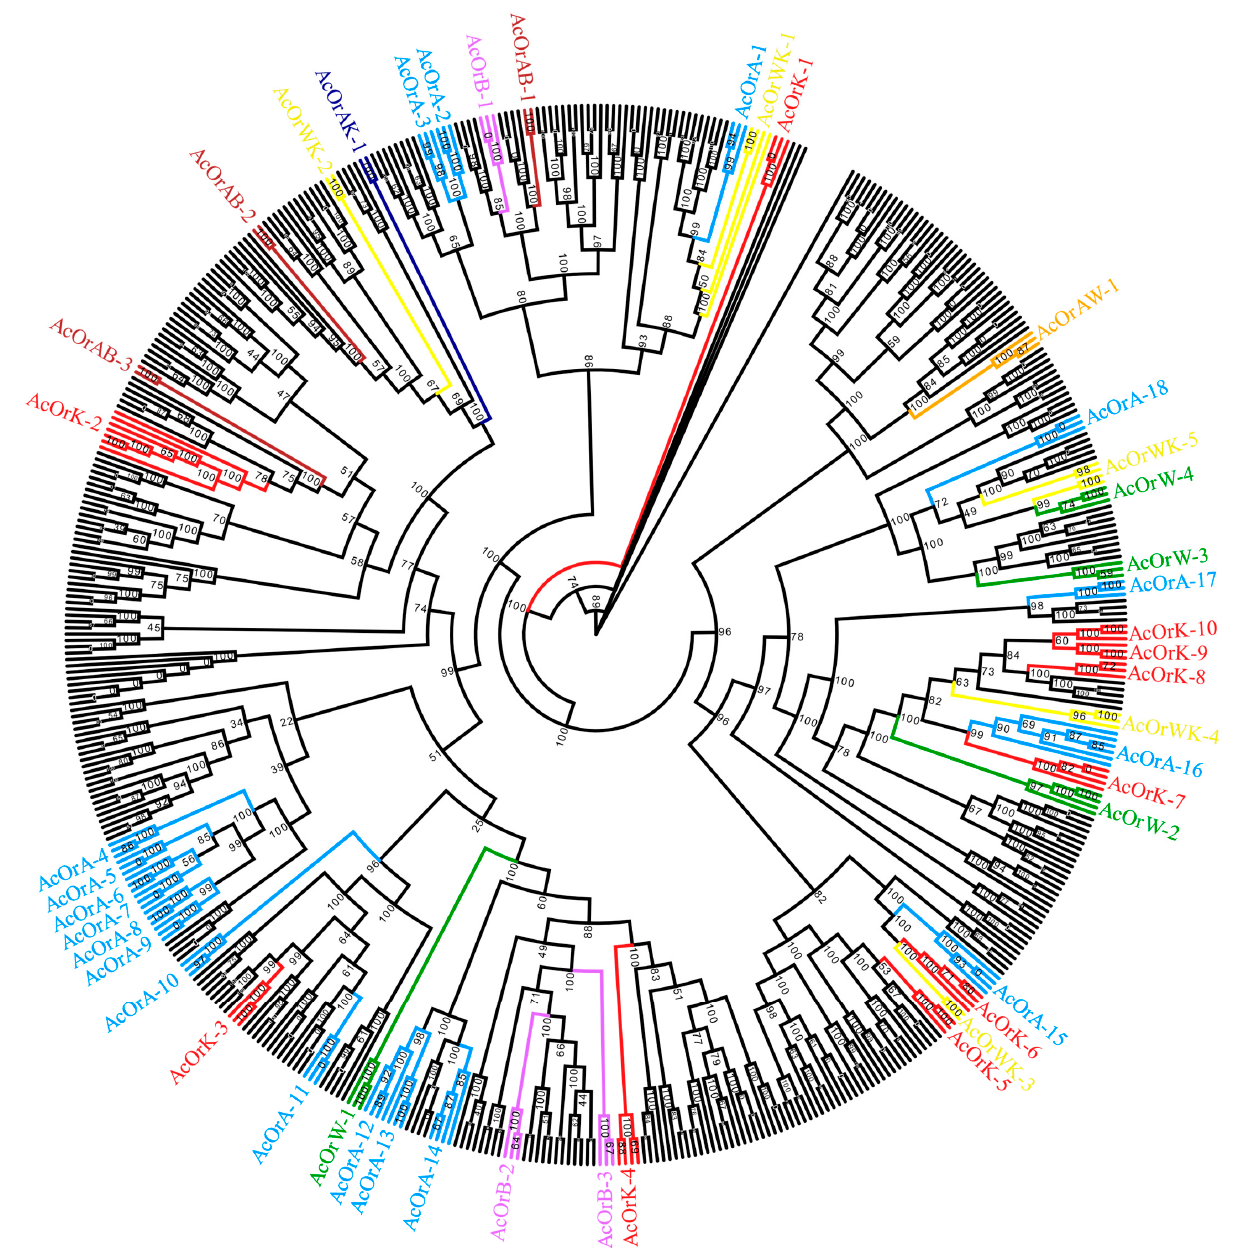
Figure 3. Phylogenetic tree constructed by odorant receptors from different A. cerana strains. Blue regions indicate only Aba lost (labeled AcOrA); purple regions indicate only Baisha lost (labeled AcOrB); red regions indicate only Korea lost (labeled AcOrK); green regions indicate only Wufu lost (labeled AcOrW); orange regions represent both Aba and Wufu lost (labeled AcOrAW); yellow regions indicate both Wufu and Korea lost (labeled AcOrWK); dark-blue regions represent both Aba and Korea lost (labeled AcOrAK); brown regions represent both Aba and Baisha lost (labeled AcOrAB).